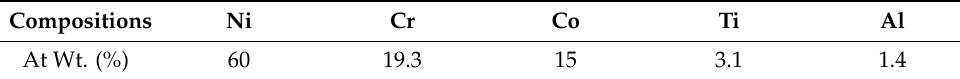
Table 2. Elemental composition of Nimonic-90.